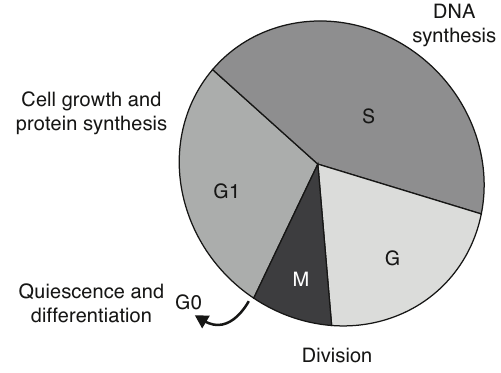
Figure 1 Phases of cell cycle. G1, S, G --- presence of